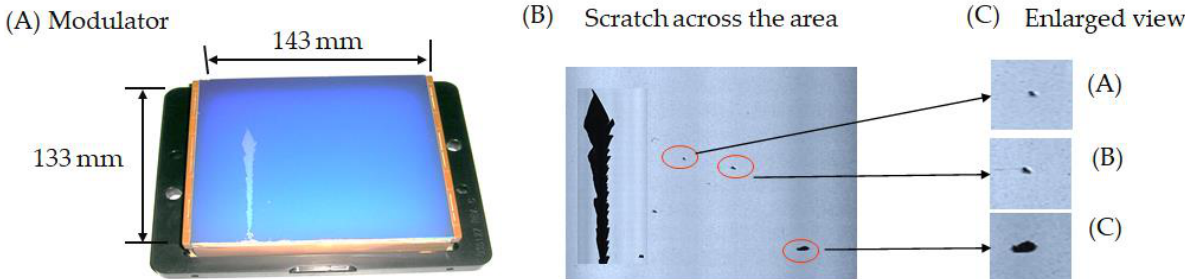
Figure 11. Analysis of the debris adhering to the modulator indicates ( A ) of the damaged modulator, ( B ) of scratch across the area, and ( C ) of the enlarged view. Figure 12 shows enlarged views of the raw and grayscale images to investigate the debris on the modulator. The images underwent a magnification of 400% to show the grayscale distribution. As a result, the calculated heights (A) 123 μm, (B) 245 μm, and (C) 687 μm were the bases of a threshold of 50 for the golden sample by transforming the square to the circle. Table 5 indicates the known heights (A) 125 μm, (B) 250 μm, and (C) 700 μm. Thus, the calculated height exceeded the known height by an error of 2% with the 3σ of 2% for the repeatability measurement. Thus, the non-contact optical detection provided high accuracy, and the damage-free significance was very impressive.